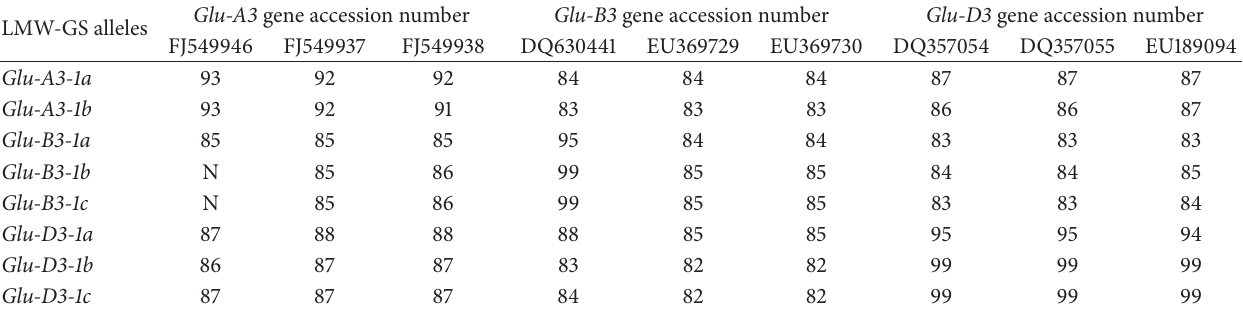
Table 2: Sequence identities of the eight new LMW-GS alleles to the previously reported Glu-3 genes. Glu-A3 gene accession LMW-GS alleles